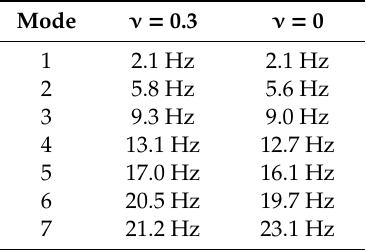
Table 2. Modes of first–seven orders.